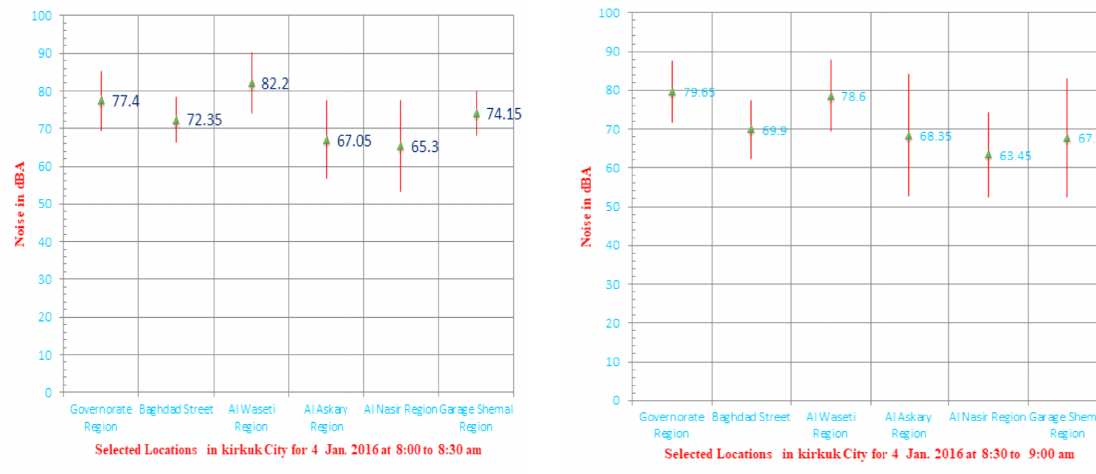
Fig. 10. Max , Min and Average Hourly Noise Distribution for the traffic flow 4 Jan. 2015 Kirkuk City.